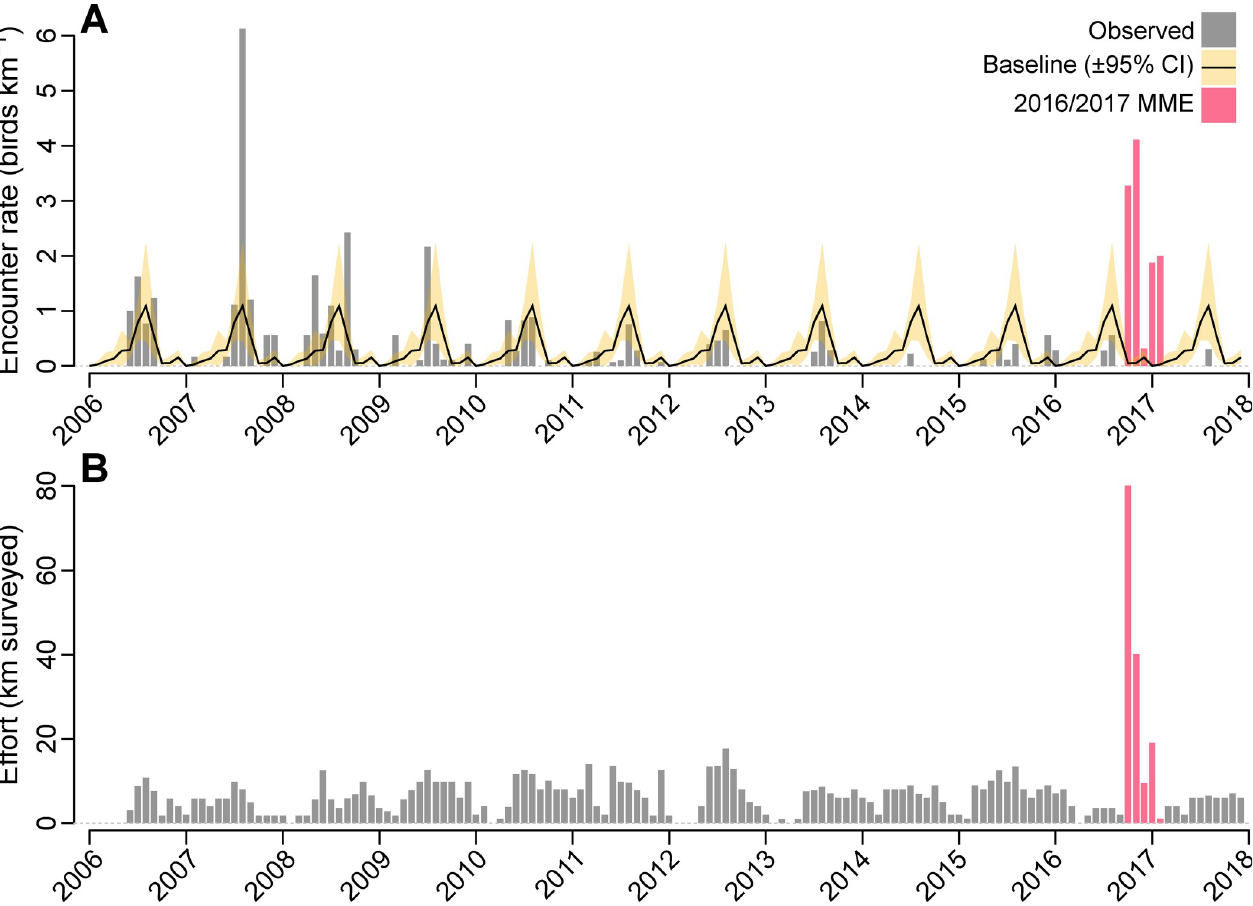
Fig 3. Time-series of effort-standardized beached bird abundance and survey effort on the Pribilof Islands, Alaska. (A) Month-averaged relative carcass abundance (carcasses km -1 ) for the Pribilof Islands, plotted as a function of time, with baseline average (monthly from 2006 to 2015 inclusive, ± 95% CI) overlaid. (B) Cumulative survey effort per month for the Pribilof Islands, plotted as a function of time. The months of the 2016/2017 event are highlighted in red.